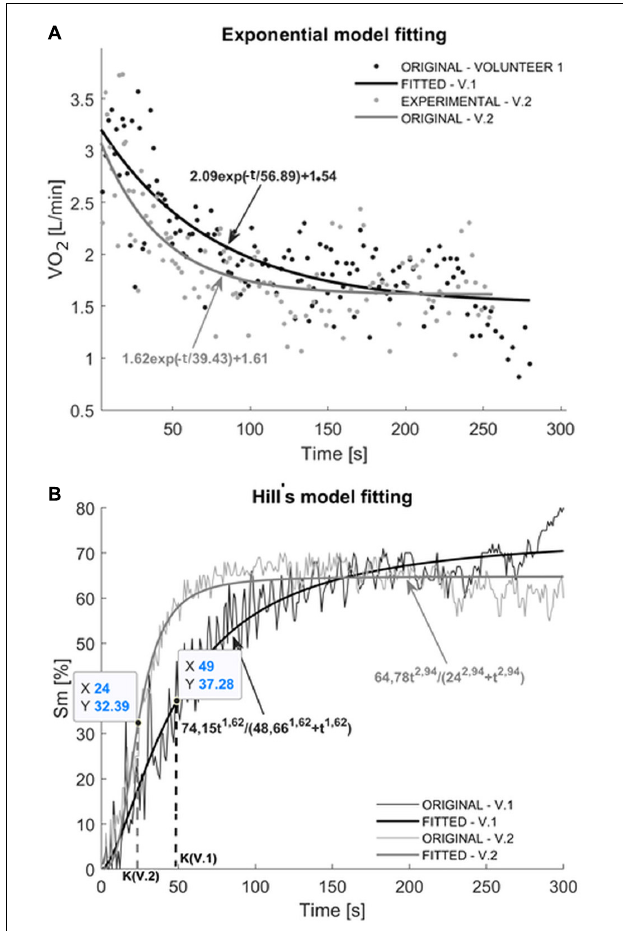
FIGURE 2 | (A) Example of oxygen uptake (VO 2 ) during the REC phase in two volunteers (V.1 and V.2) with fitted theoretical values derived from the exponential model. (B) Effect of fitting the Hill’s model to the experimental oxyhemoglobin concentration (Sm) data during the recovery for two study